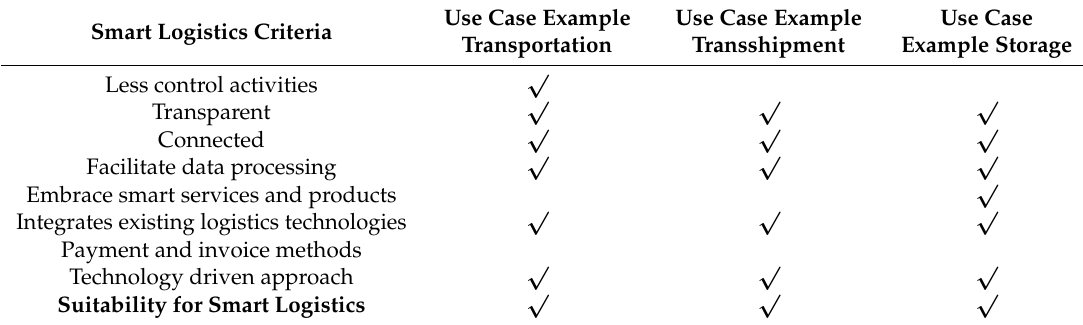
Table 1. Suitability for smart logistics of the considered use case